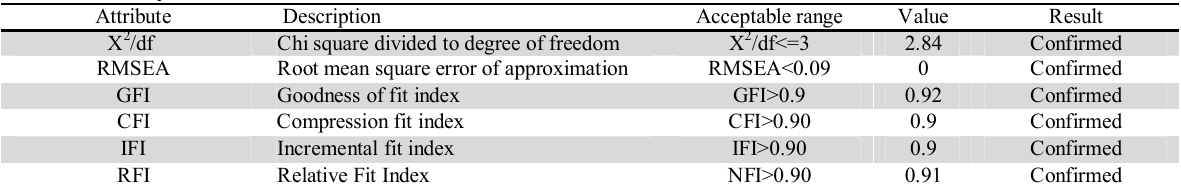
The summary of statistical observations